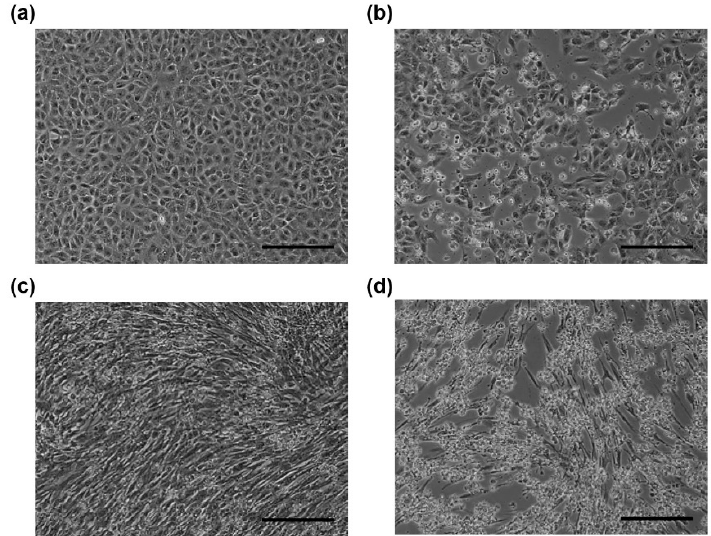
Figure 1. Microscopic images of African green monkey kidney cells (Vero E6) ( a ) and ( b ) and baby hamster kidney (BHK) ( c ) and ( d ) cells. Mock-infected cells ( a ) and ( c ) and PSV-infected cells ( b ) and ( d ) were observed at 24 h post-infection. The cells infected with PSV-20-V ( b ) or PSV-26-B ( d ) showed cytopathic effects. Scale bars represent 200 µm. Table 3. Summary of Zambian PSVs whose full genome sequences were determined.